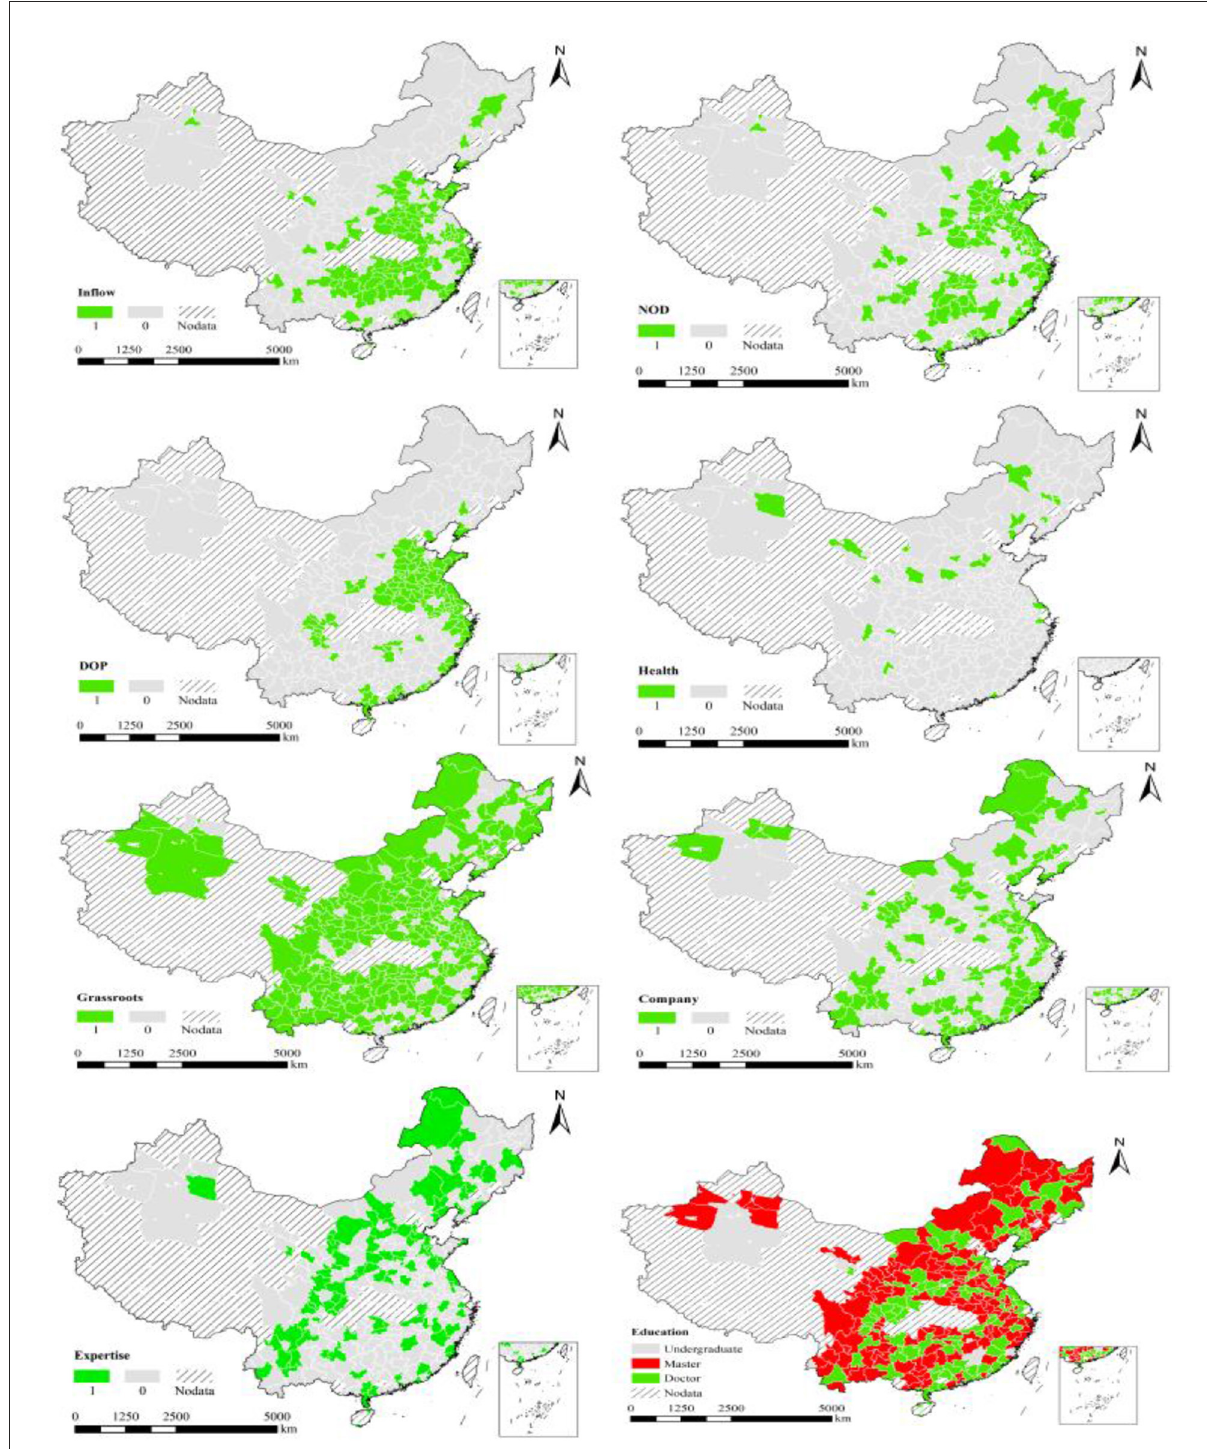
FIGURE2 Results in visual map. Inflow, DOP, NOD refer to the population inflows from Wuhan, the density of the population, the number of doctors per 100,000 people respectively. Grassroots, Health, Company refer to work experience in the corresponding department. Expertise refers to the different expertise of different leader team members. Education refers to the highest level of education within the leader